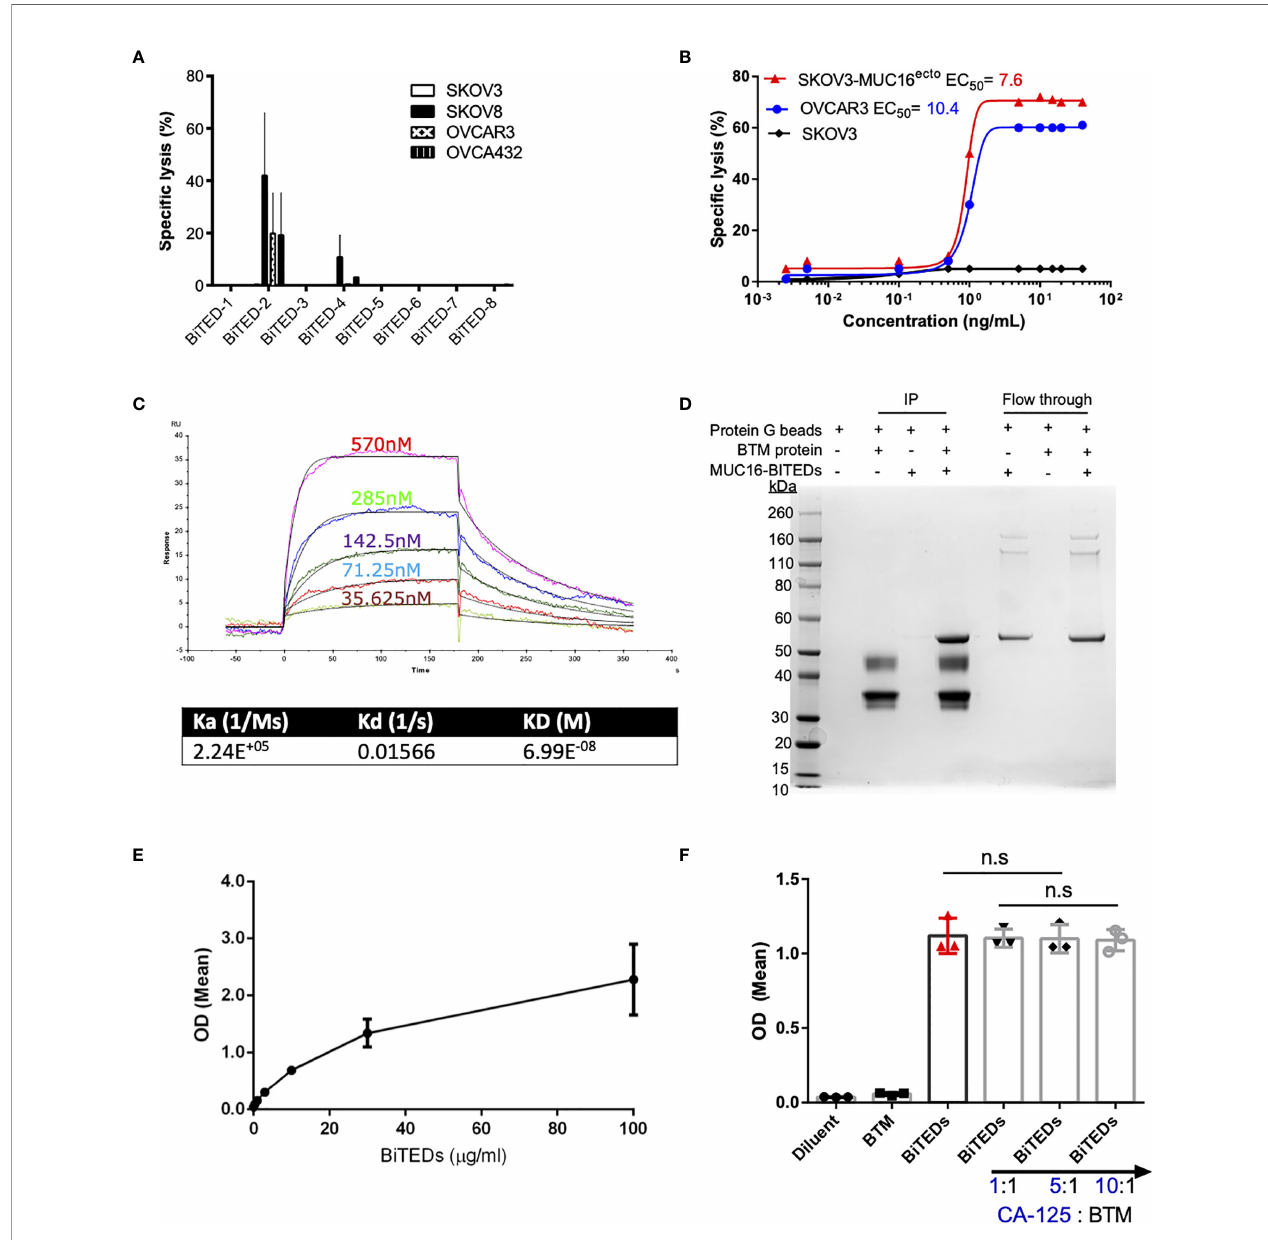
FIGURE 2 | Validation of lead MUC16 ecto -BITEDs candidate, evaluation of binding to MUC16 ectodomain and potential interference by soluble CA-125. (A) Evaluation of cytotoxicity via 1:1 E:T coculture of SKOV3, SKOV8, OVCAR3, OVCAR432 and activated T-cells with the indicated BiTEDs. (B) Increasing concentrations of MUC16 ecto -BiTEDs cocultured with MUC16 positive SKOV3 (SKOV3-MUC16 ecto ), OVCAR3, and MUC16 negative SKOV3 cell lines, and PBMC for 48 hrs PBMC (E:T = 10:1). Cytotoxicity determined by LDH release assay. (C) Kinetic analysis was performed to determine the dissociation constant of MUC16 ecto - BiTEDs to the highly conserved 55mer MUC16 ectodomain. (D) BTM protein was immunoprecipitated (IP) with MUC16 ecto -BiTEDs (lane 4). Control conditions; Protein G agarose beads alone (lane 1), protein G beads with BTM protein (lane 2) or with MUC16 ecto -BiTEDs (lane 3) did not show the expected 55 KDa band representing MUC16 ecto -BiTEDs. Unbound MUC16 ecto -BiTEDs but not BTM protein were detected in fl ow through (lanes 5-7). (E) ELISA showing binding of increasing concentrations of MUC16 ecto -BiTEDs in the presence of BTM. (F) ELISA showing binding of diluent and MUC16 ecto -BiTEDs in the presence of increasing concentrations of recombinant human CA-125. For (A, B) , data shown are pooled results from 3 independent experiments with 3 independent donors. Data are plotted as mean ± SEM. Results from (E, F) are pooled from 3 independent experiments. Data are plotted as mean ± SEM. ns, not signi fi